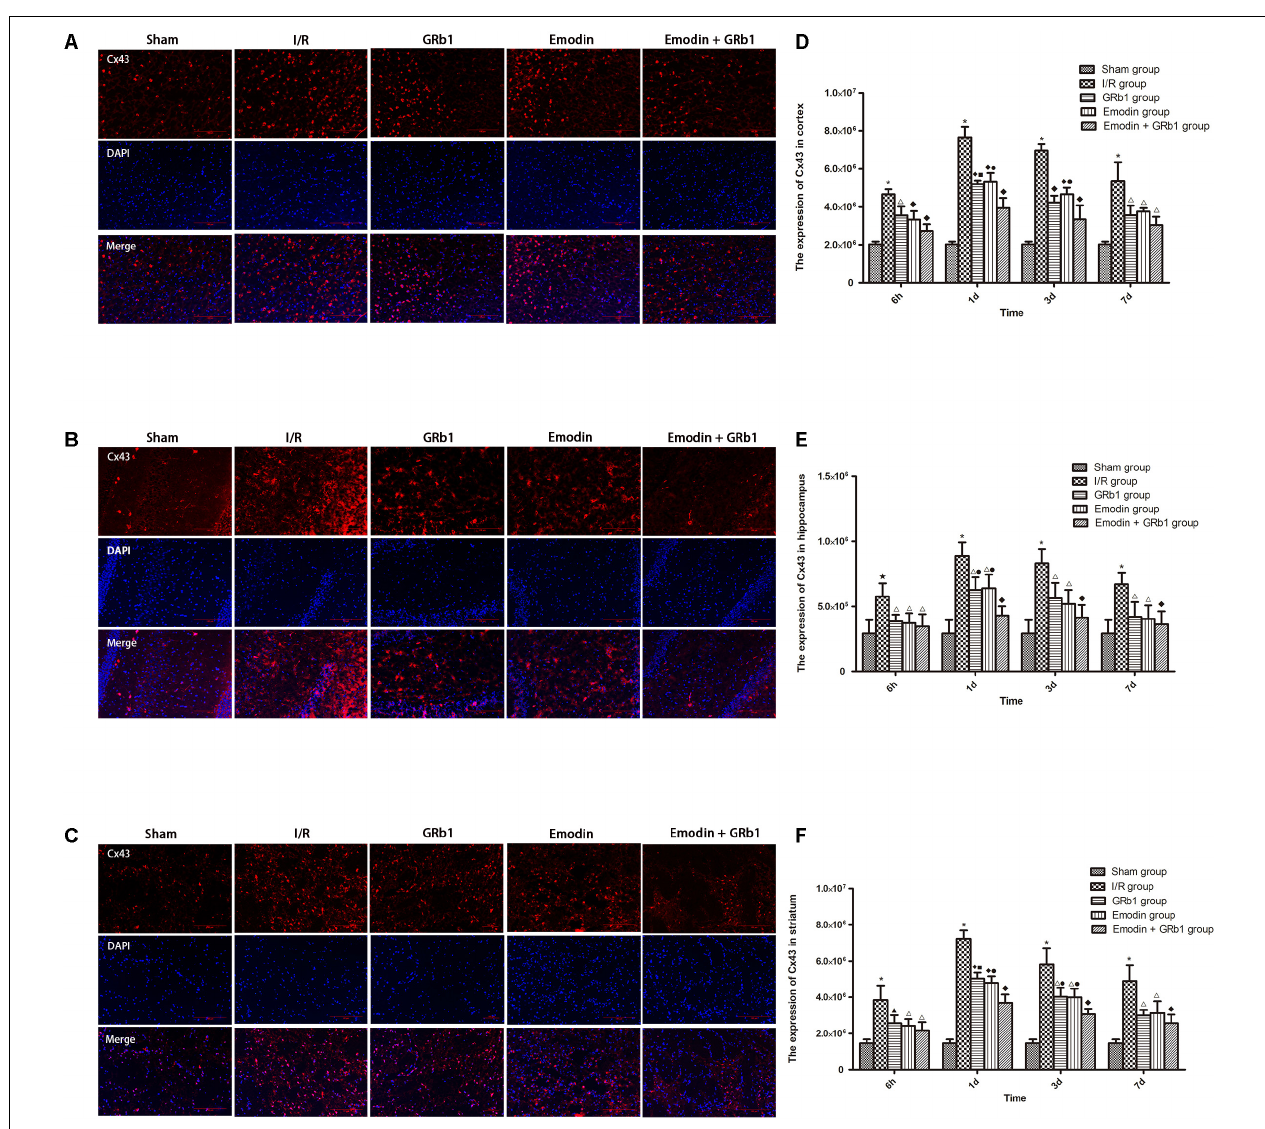
FIGURE 5 | Immunofluorescence staining of Cx43 in I/R rats (mean ± SD, n = 5). (A–C) The expression of Cx43 in (A) cortex, (B) hippocampus, and (C) striatum with immunofluorescence staining. (D,E) Quantitative analysis for the results of (A–C) . One-way analysis of variance (ANOVA) was used for multiple group experiments comparisons and followed by Dunnett test for comparison of two groups within the multiple groups. (cid:70) p < 0.01, ∗ p < 0.001, compared with Sham group. (cid:78) p < 0.05, (cid:77) p < 0.01, (cid:7) p < 0.001, compared with I/R group. • p < 0.01, (cid:4) p < 0.001, compared with the Emodin+GRb1